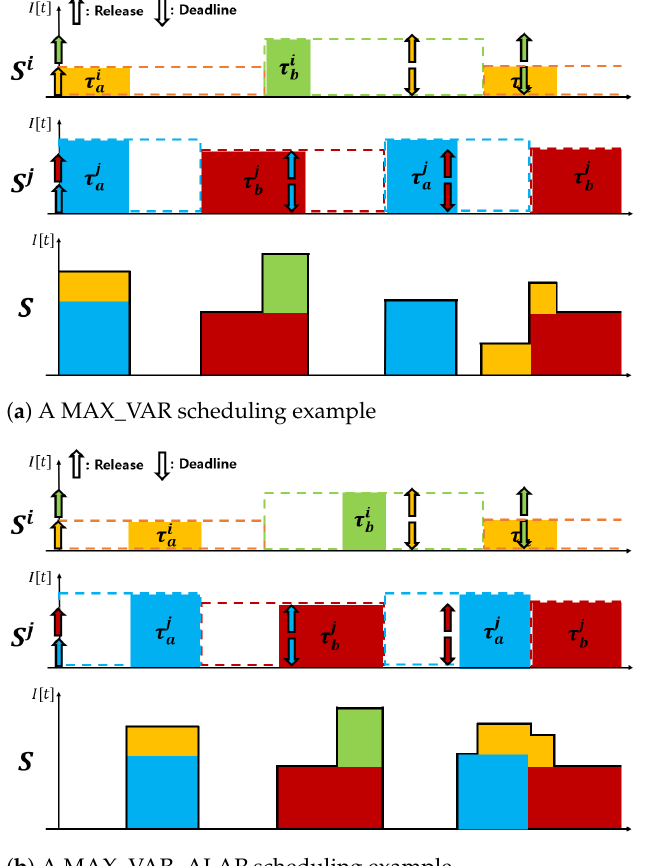
Figure 5. Examples of scheduling and current dissipation traces from the proposed on-line scheduling policies: ( a ) maximizing the variance (MAX_VAR) and ( b ) maximizing the variance while keeping the execution as late as possible